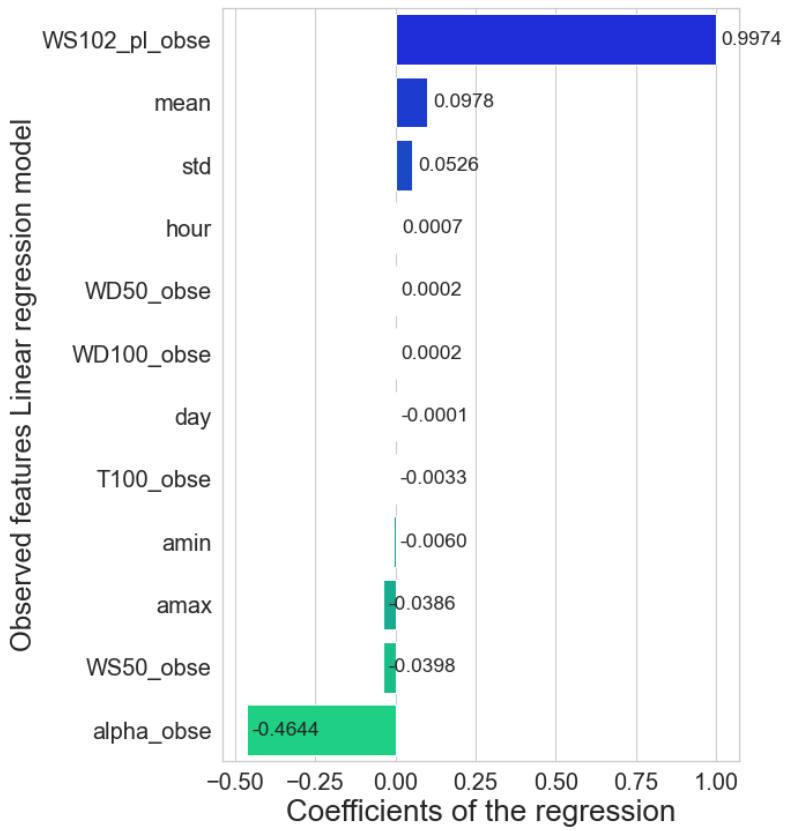
Figure 15. Feature importance for linear regression in Scenario